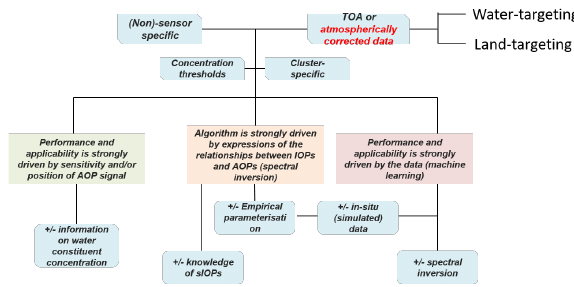
Figure 4. Overview of retrieval algorithms used in EO of inland and coastal waters